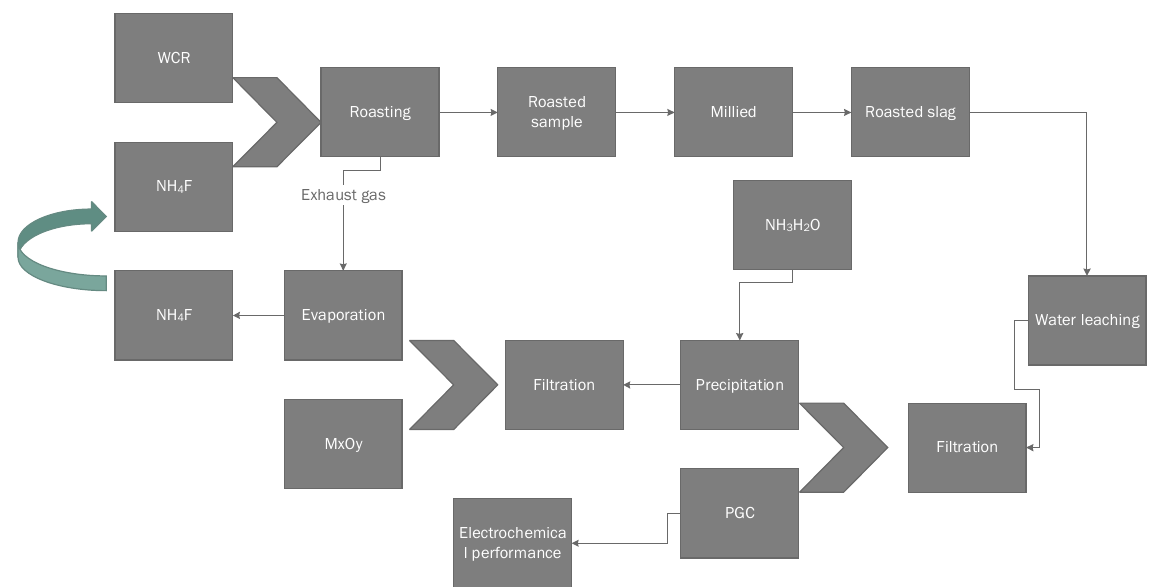
Figure 10. Flow diagram of high-purity graphite carbon and metal recovery from WCR, redrawn from Zhu, Xiao, Mao, Zhang, You, Tang and Zhong